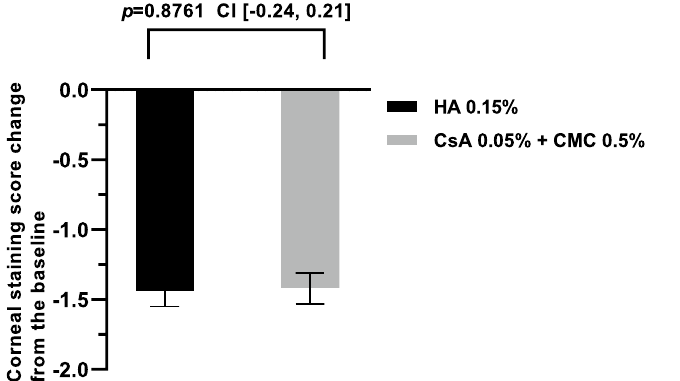
Figure 2. Corneal staining score change from baseline to 12 weeks in each per-protocol set group. Changes in corneal staining score during the follow-up period of 12 weeks in HA 0.15% group and CsA 0.05% + CMC 0.5% group showed no significant difference (Mean value ± standard deviation, P > 0.05 by analysis of